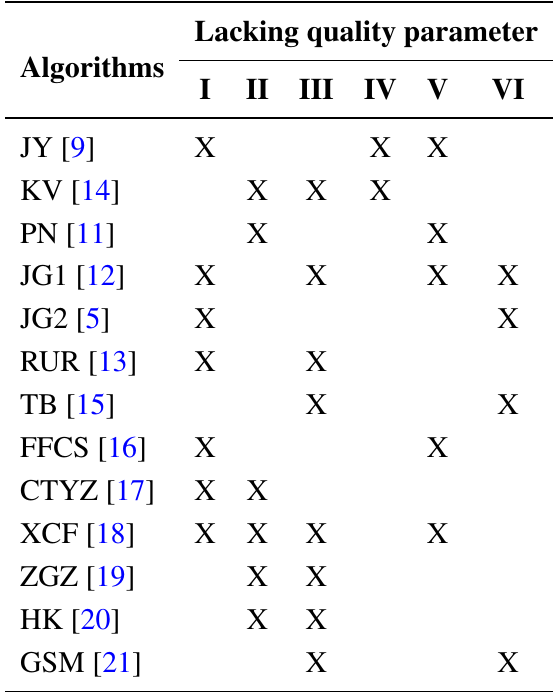
Table 1. Summary of the lacking quality parameter on fingerprint matching algorithms based on minutiae